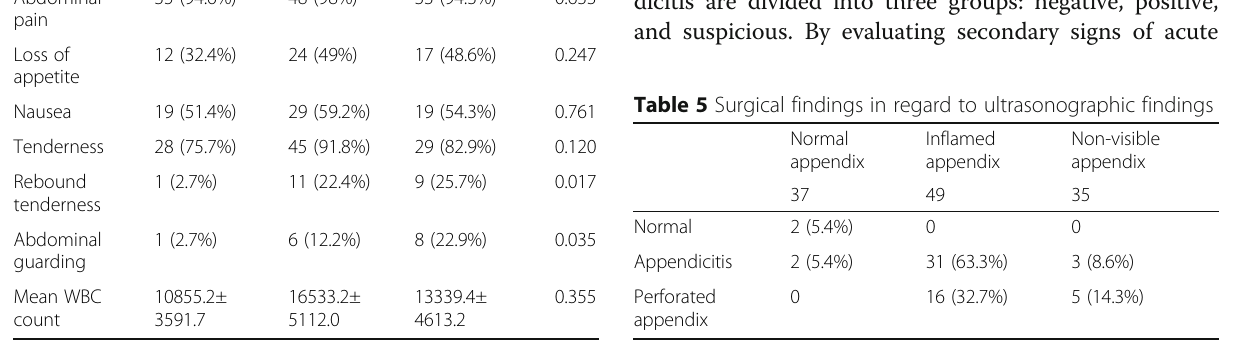
Table 4 Clinical signs and symptoms in patients being studied, in regards to ultrasonographic findings Signs and symptoms